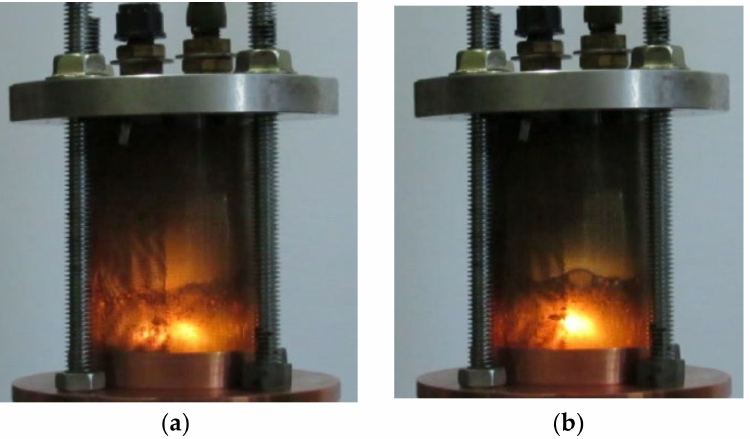
Figure 5. Two successive frames of microwave discharge in n -heptane in installation with coaxial input of microwave energy described in [41,43–45] (shooting speed is 25 frames per second, time interval between figures ( a ) and ( b ) is 40